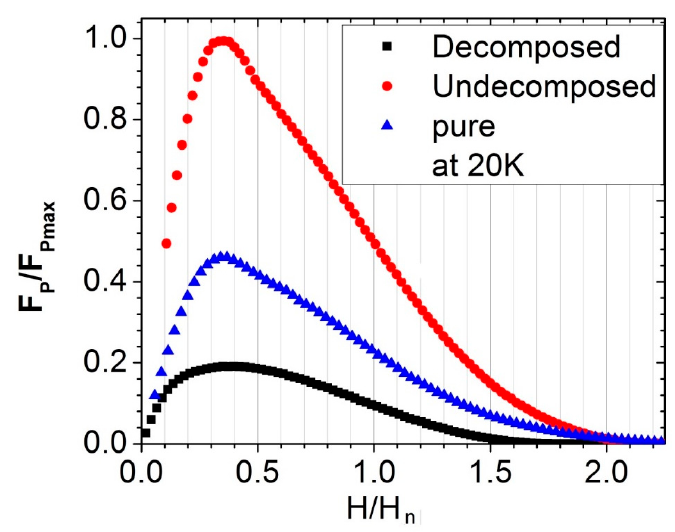
Figure 9. The plot of the relative pinning force as a function of the relative magnetic field .